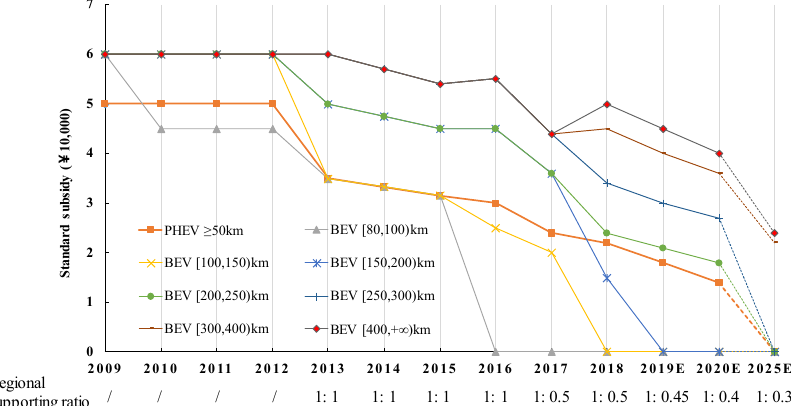
Figure 1. The development and prediction of the subsidy scheme in China. Notes. (1) The subsidies in 2019, 2020, and 2025 are all predicted based on the historical plan from 2016–2018. (2) In order to fully evaluate the substitution effect, two scenarios with and without subsidies are constructed in 2025.